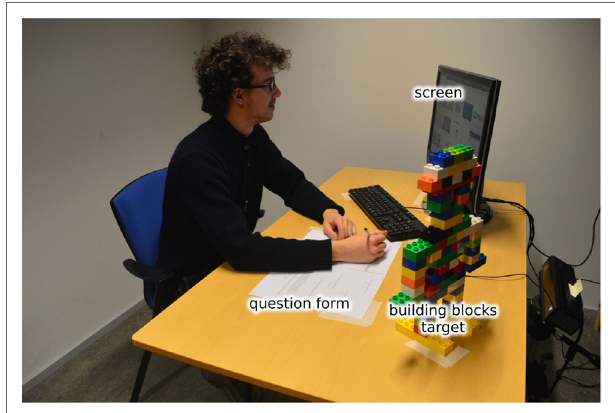
FigUre 4 | Experimental